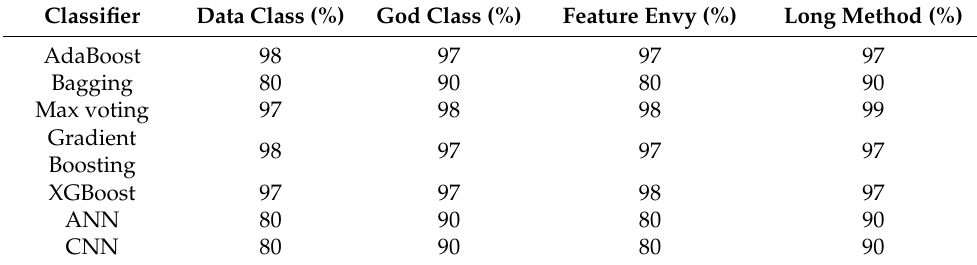
Table 17. Statistical